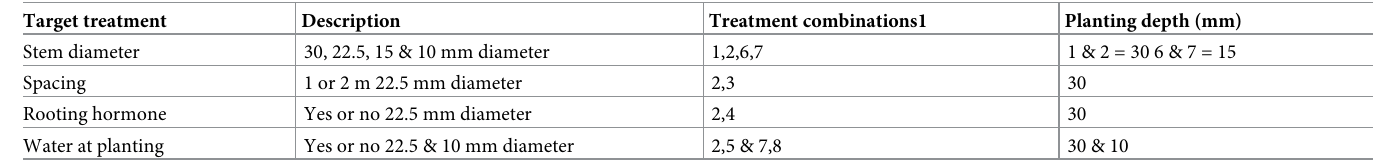
Table 2. Combinations of treatments for assessing impacts of a specific treatment on the survivorship of spekboom ( Portulacaria afra ) truncheons (see Table 1 for description of